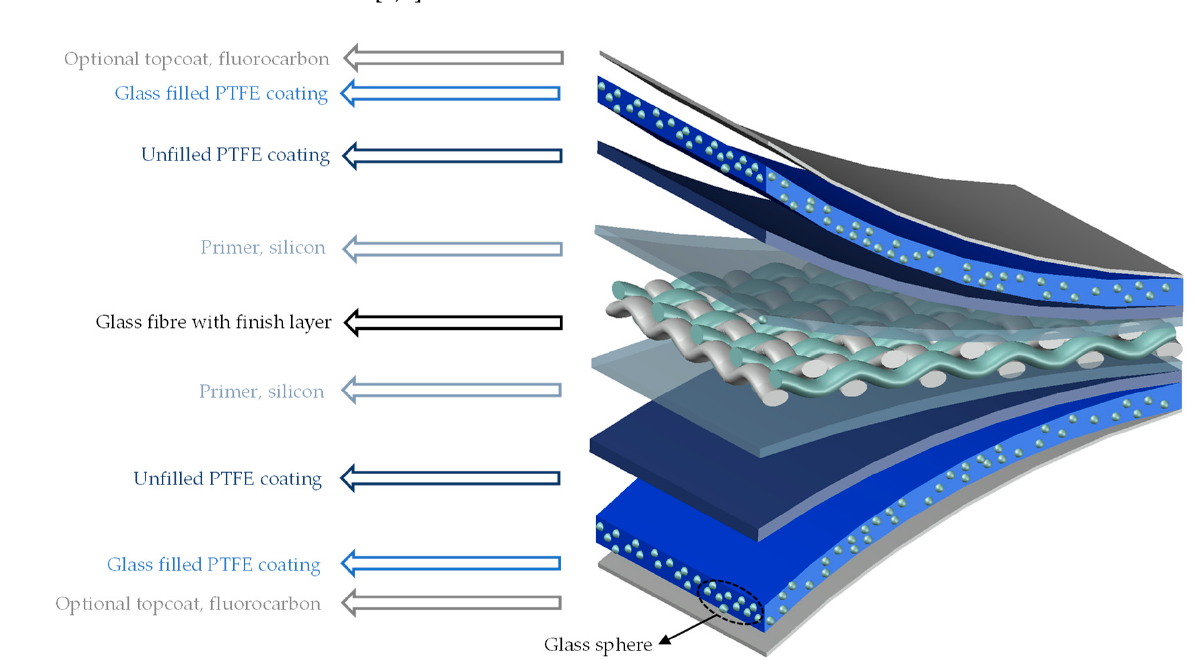
Figure 1. Schematic view of a glass-PTFE composite based on [3].